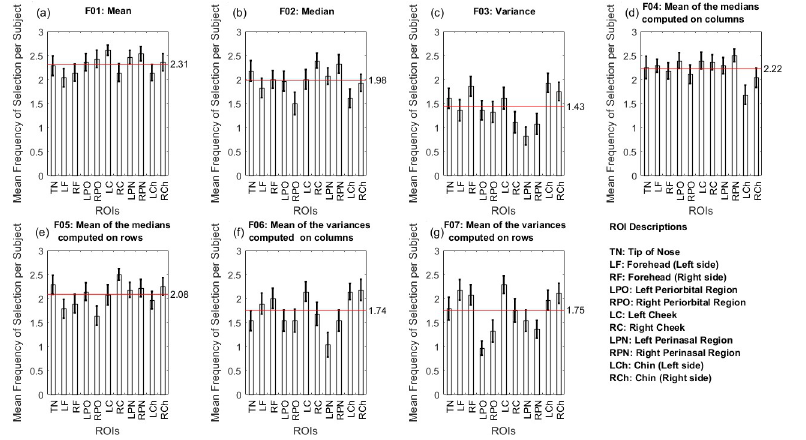
Fig 4. Mean frequency of feature selection per ROIs per subject.